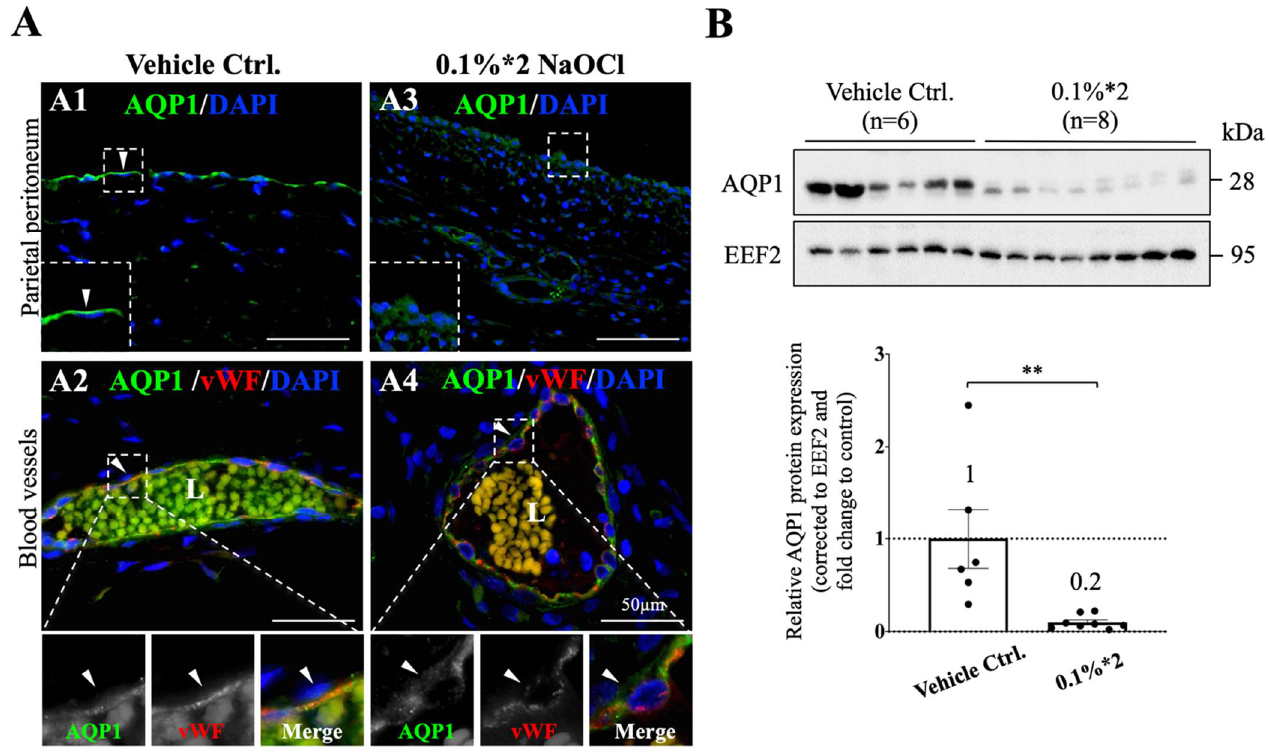
Figure 3. Cellular localization and protein expression of peritoneum AQP1 was altered in NaClO- injured pigs. ( A ) Immunofluorescent staining showed that AQP1 appeared on both mesothelial cells ( A1 ) and endothelial cells ( A2 ) that surrounded vessels. AQP1 was double stained with vWF to confirm the identity of an endothelial cell. In the vehicle control group, AQP1 mainly appeared on the apical and adluminal region of cells (white arrowheads); however, after 0.1%*2 NaClO injury, signals of AQP1 on both types of cells became weakened ( A3 ) and more scattered into the cytosol ( A4 ). ( B ) Quantitative analyses on whole peritoneal tissue homogenates showed that total protein expression of AQP1 on parietal peritoneum was significantly decreased (80% less) in 0.1%*2 NaClO- injured pigs. Eukaryotic elongation factor 2 (EEF2) was used as protein loading control, AQP1 signal was first corrected with loading control EEF2 before fold change comparisons to control animals. L